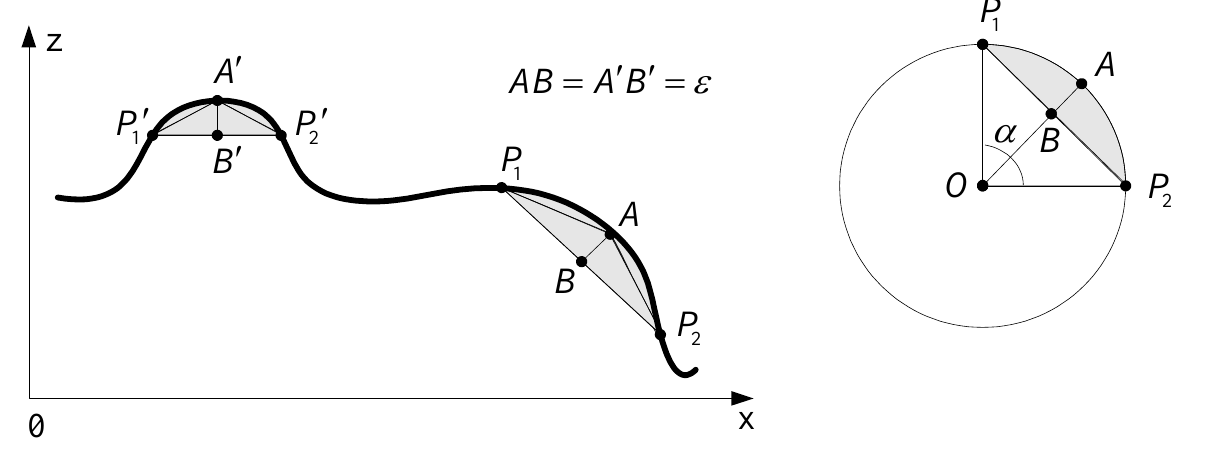
Figure 2. Schematic view of the curvature detector operation. The radius R of the particle osculating circle is computed from the figure P 1 OB :